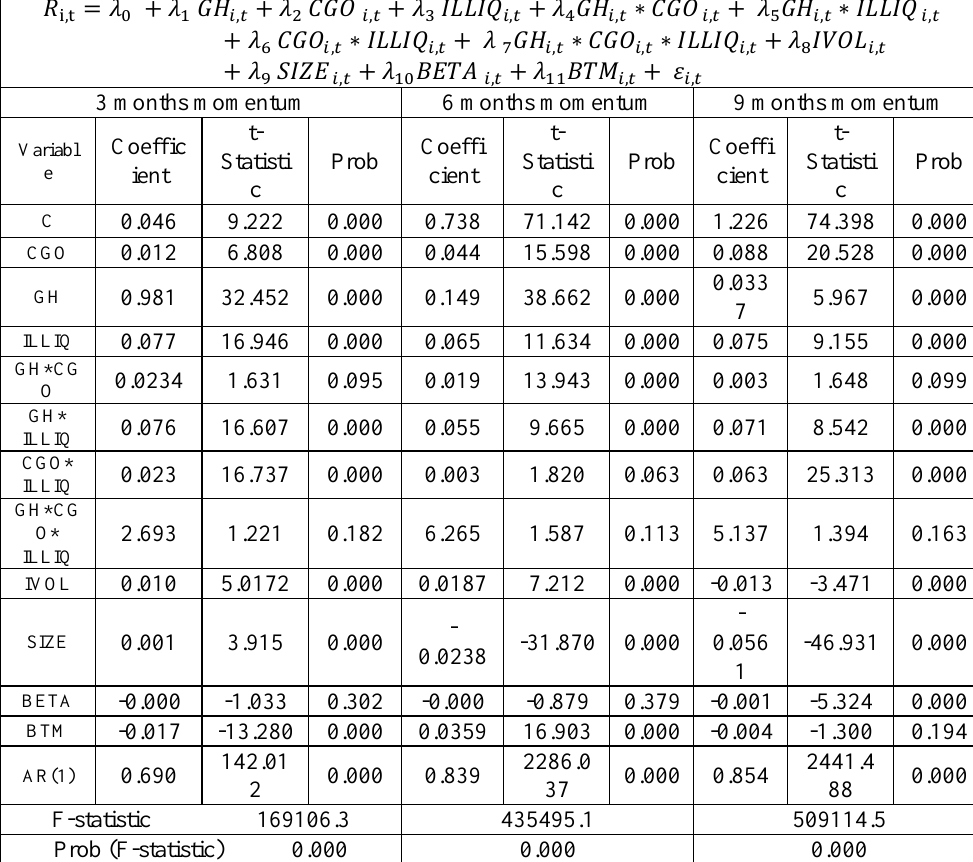
Table 5. Results of testing the forth research